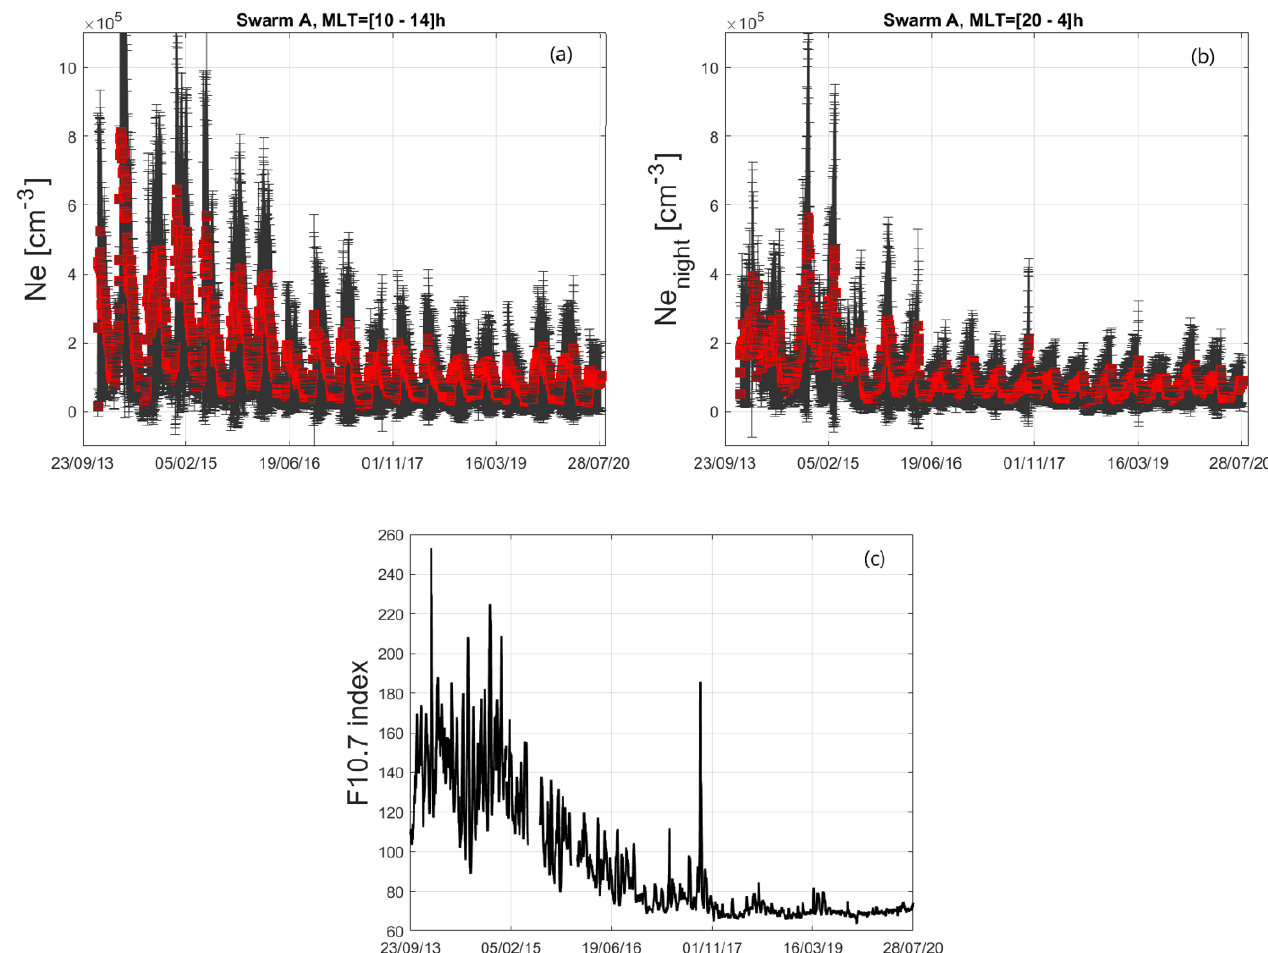
Figure 6. Orbital averages of the electron density variation (red squares) with standard deviations (vertical bars) during (a) ascending and (b) descending orbit phases, observed by Swarm A from December 2013 to July 2020. Panel (c) displays the F10.7 index in solar flux units for the same period. Similar results are obtained also for Swarm B and C (not